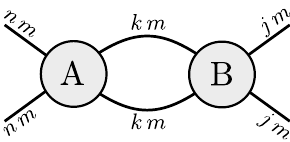
Figure 7: The Landau curve of a graph AB that has a 2-particle cut is related to the singularities of sub-graphs A and B . The numbers indicate the mass of “on-shell" particles as integer multiples of m